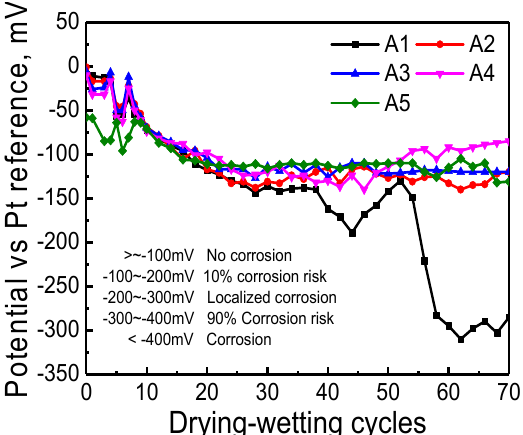
Figure 10. Potential (against Pt reference) evolution with the development of dry-wet cycles of ALS in mortar sample.